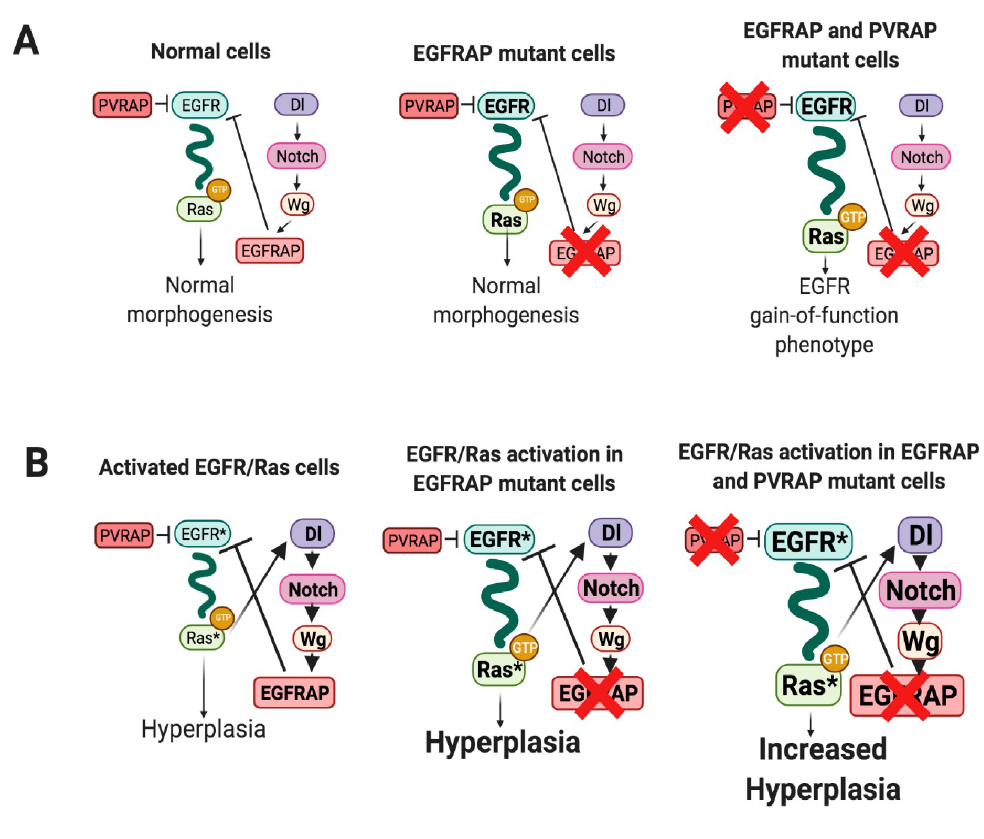
Fig 8. Model of EGFRAP function as a modulator of EGFR/Ras-dependent tissue hyperplasia. Schematic drawing depicting the mechanisms by which EGFRAP could limit EGFR/Ras activity in normal (A) and Ras V12 -dependent oncogenic cells (B). (A) In normal cells EGFRAP and PVRAP act as negative regulator of the EGFR. Expression of EGRAP is confined to cells with high levels of EGFR activity via the Notch pathway. EGFRAP elimination results in a slight increase in EGFR activity, which does not seem to affect normal morphogenesis. However, the simultaneous elimination of EGFRAP and PVRAP leads to a further enhancement of EGFR signaling with consequences in normal morphogenesis. (B) Oncogenic EGFR/Ras activity promotes, via activation of the Notch pathway, an increase in EGFRAP expression that, in turn, restrains both EGFR activity and its capacity to induce hyperplasia. Downregulation of EGFRAP releases this restraint leading to a further increase in EGFR/Ras pathway activity and tumor growth, which is enhanced by elimination of PVRAP .